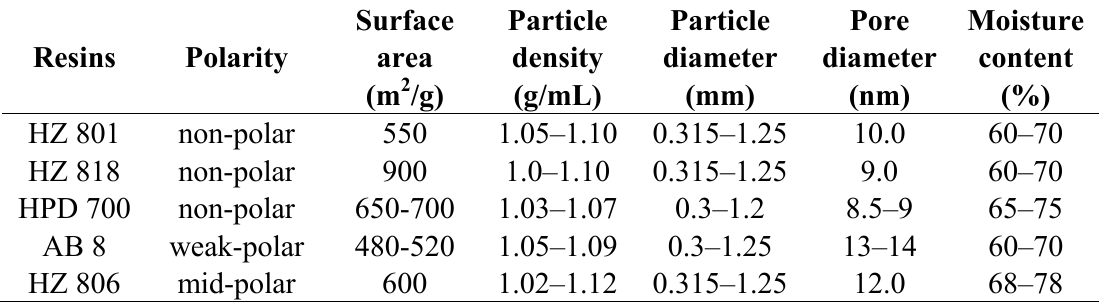
Table 4. Chemical and physical characteristic of